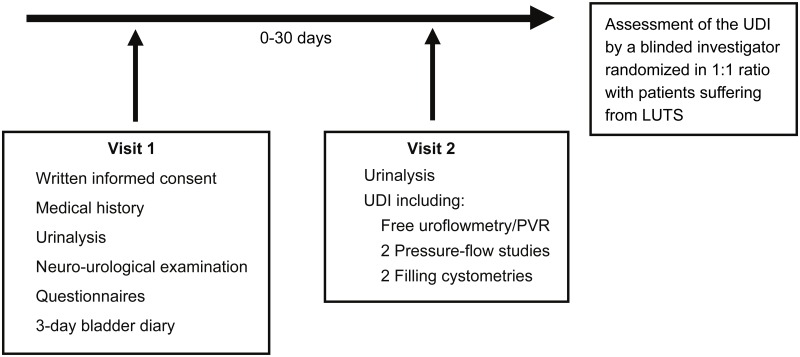
Flow chart of all visits.On subjects’ request UDI could be performed at the first visit, if the 3-day bladder diary was already available and all further inclusion criteria were met. LUTS = Lower urinary tract symptoms, PVR = Post void residual, UDI = Urodynamic investigation.